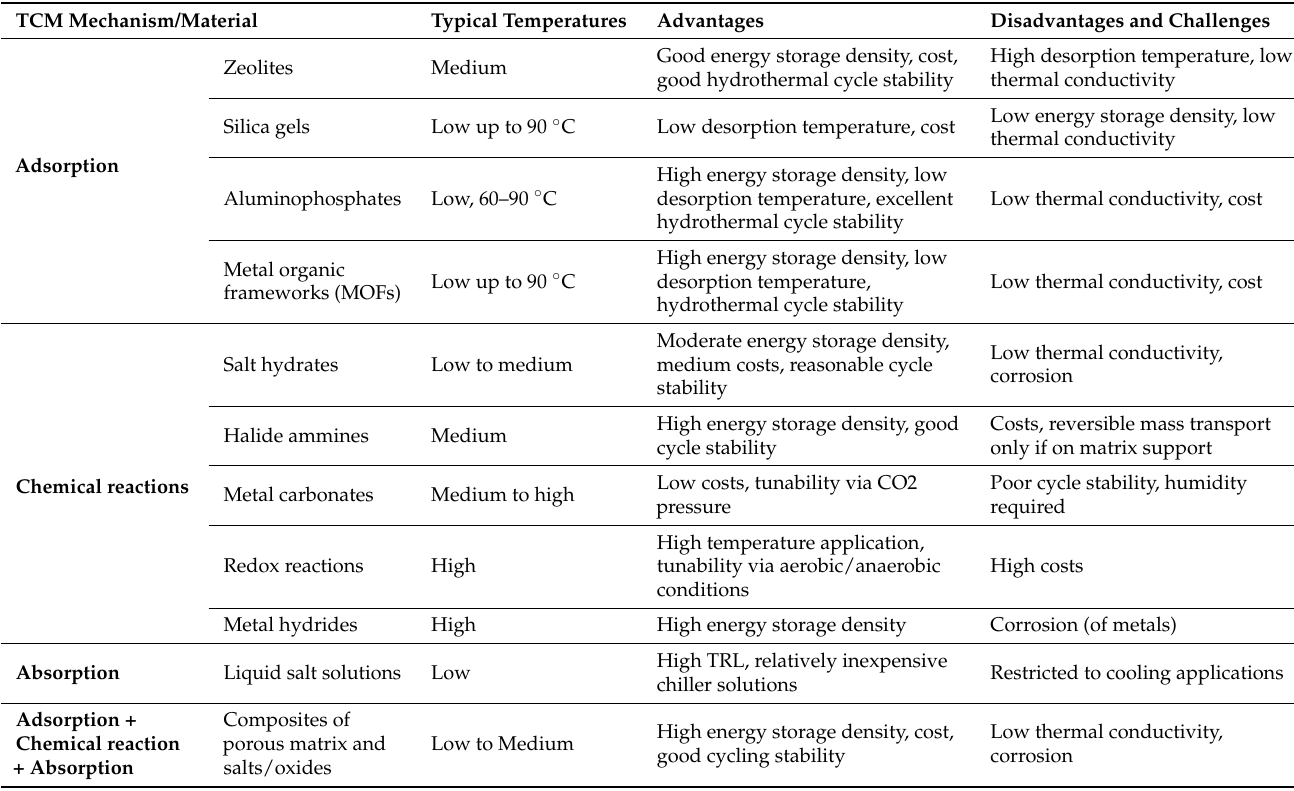
Table 6. Advantages and disadvantages of various TCM categories (here the temperature ranges provided are just indicative but not exclusive. Low, medium, and high temperatures represent below 100 ◦ C, ~100–450 ◦ C and above ~450 ◦ C, respectively). TCM